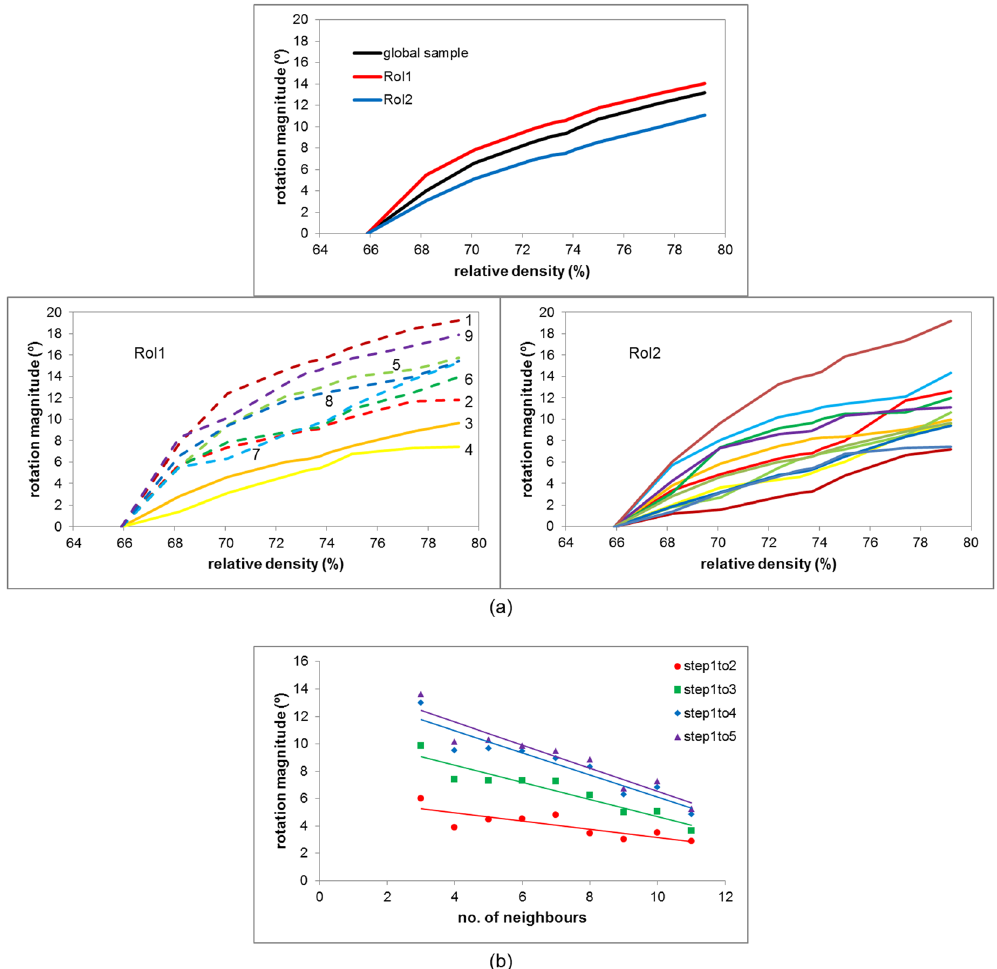
Figure 3. Quantification of particle rotations and effect of particle coordination. ( a ) Top: Plot of the average rotation of particles in the two RoIs illustrated in Fig. 2 and globally for the whole sample, as a function of relative density. The rotations are cumulative over the incremental sintering steps. Below: Cumulative rotations of individual particles in RoI1 (left, 9 particles) and RoI2 (right, 12 particles). The rotation profiles for particles in RoI1 are numbered corresponding to the particle numbers in Fig. 2(b). Particles in RoI1 that lie on the surface of the sample are shown with dashed lines. ( b ) Showing the mean particle rotations relative to the original arrangement as a function of the number of contacting neighbours, for the whole sample